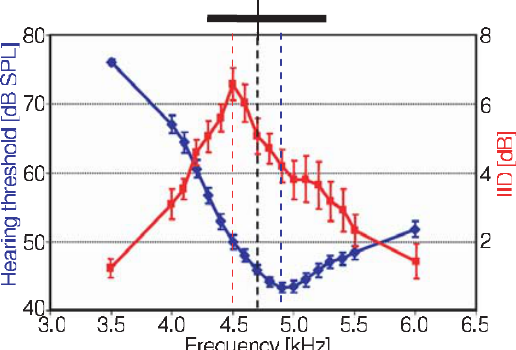
Figure 4. Summary of two matched filters . Whereas the average AN1-neuron is tuned to 4.9 kHz (blue), the peripheral directionality is tuned to 4.5 kHz (red). The calling song frequencies of males vary from 4.3 to 5.3 kHz (horizontal bar; mean 4.7 kHz; broken line), indicating that the combined action of both receiver biases exerts a stabilizing selection pressure on this male